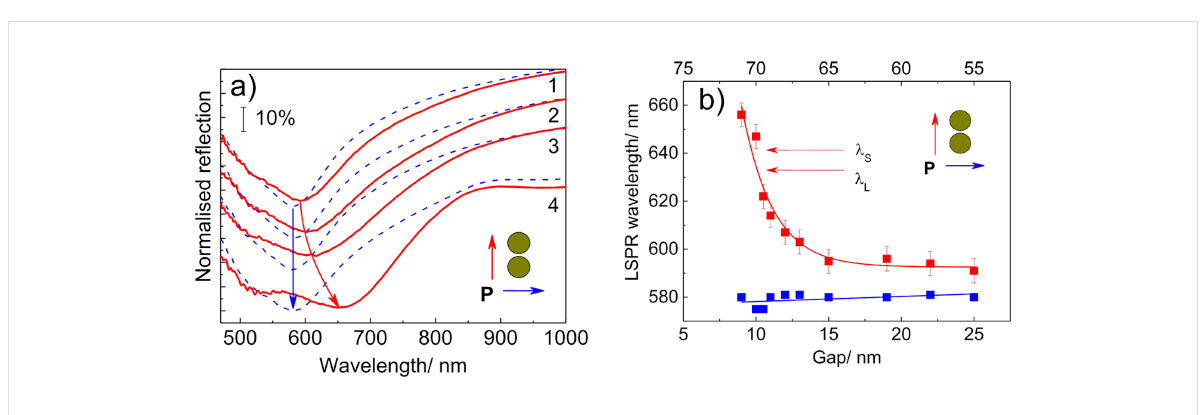
Figure 5: (a) The representative reflection spectra of Au dimer arrays with decreasing gap size ( Δ = 15 cm, 1; Δ = 13 cm, 2; Δ = 10 cm, 3; Δ = 8 cm, 4) measured with light polarized parallel to (solid) and perpendicular to (dashed) the long dimer axis. (b) The dependence of the LSPR wavelength on the gap size, Δ , between dimers. The arrows show the laser excitation wavelength, λ L , and the wavelength of the scattered photons, λ S